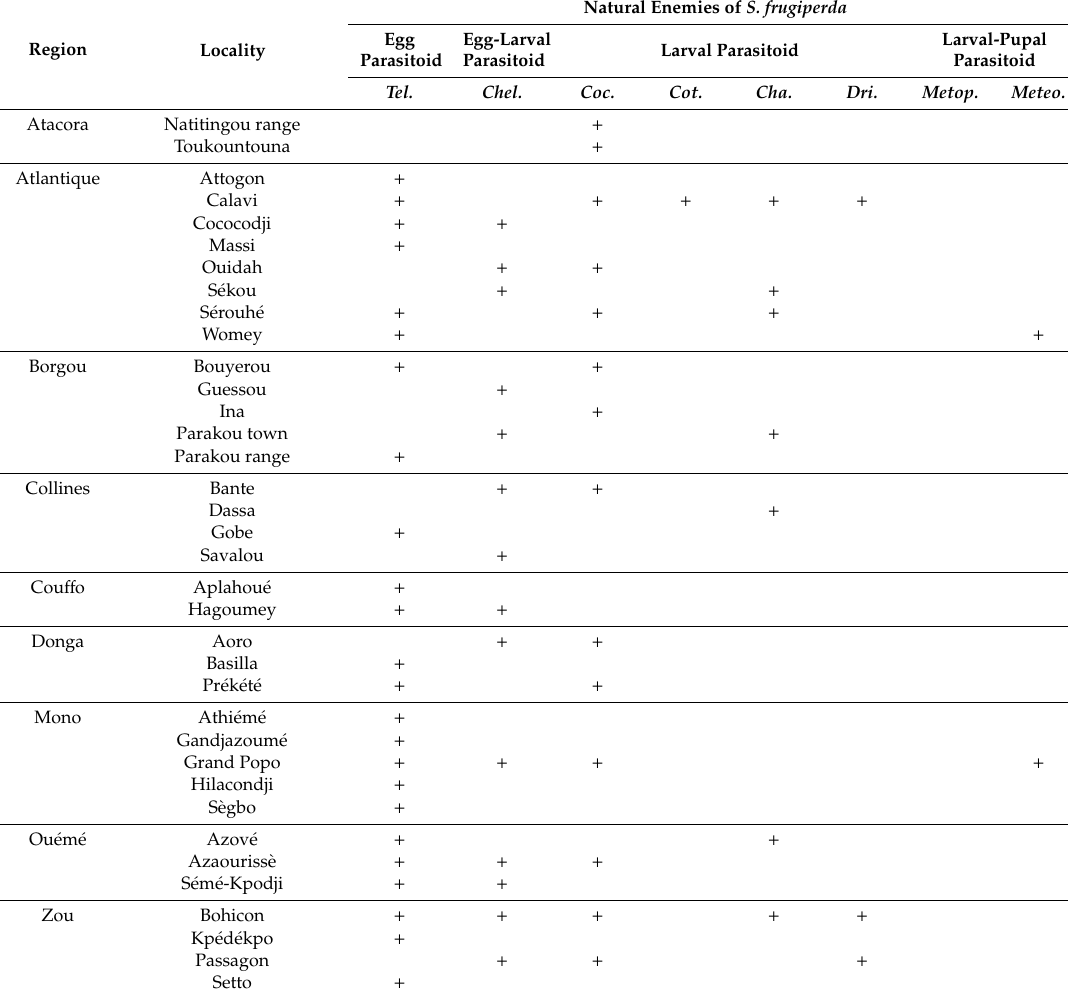
Larval-Pupal Parasitoid